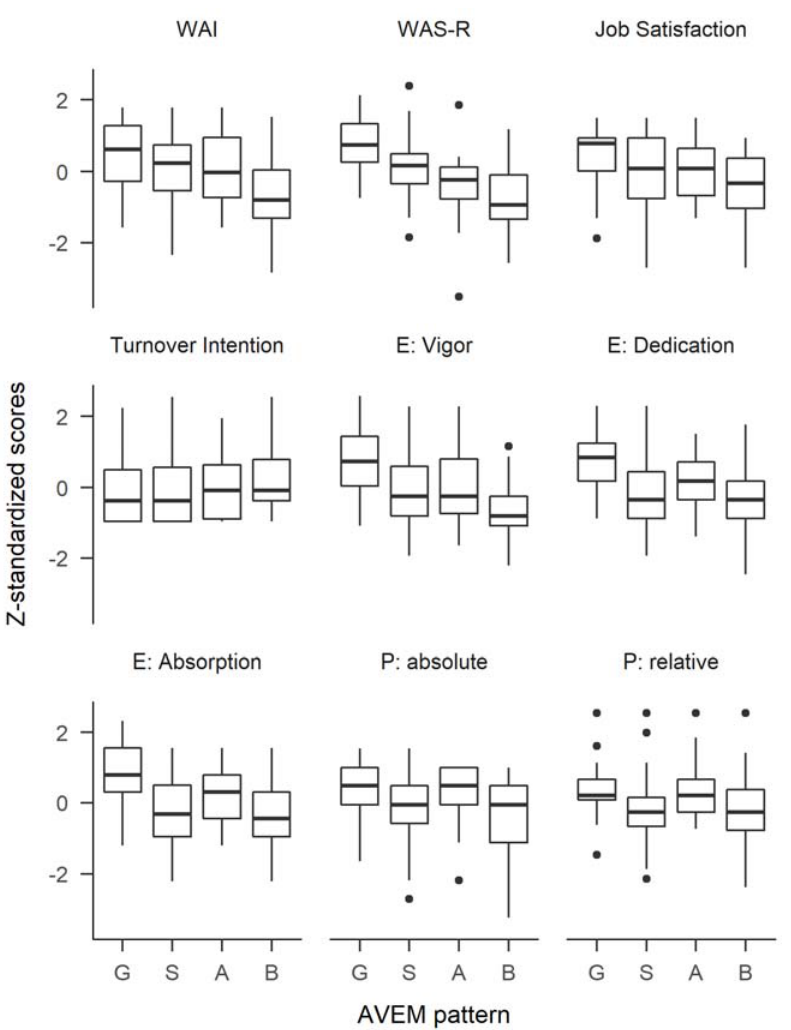
Figure 2. Distribution of other work ‐ related variables within the four work ‐ related behavior and experience patterns G “Health”, S “Unambitious”, A “Overexertion”, and B “Burnout”.